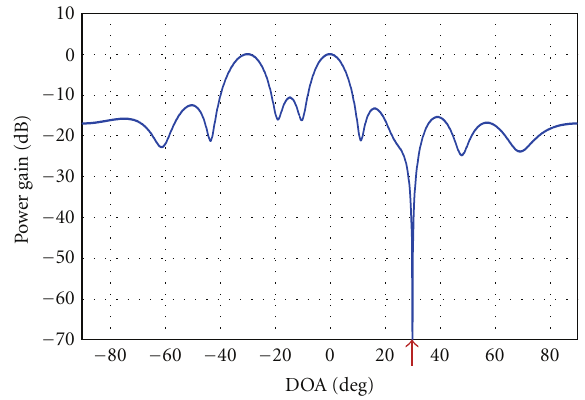
Figure 12: Adapted beam pattern of an antenna array with two desired signals ( − 30 ◦ , 0 ◦ ) and one interfering source (30 ◦ ). Inter- fering signal is correlated to signal at − 30 ◦ . α = ( − 0 . 15,0 . 05), c = [1 1 0]; compare [136].